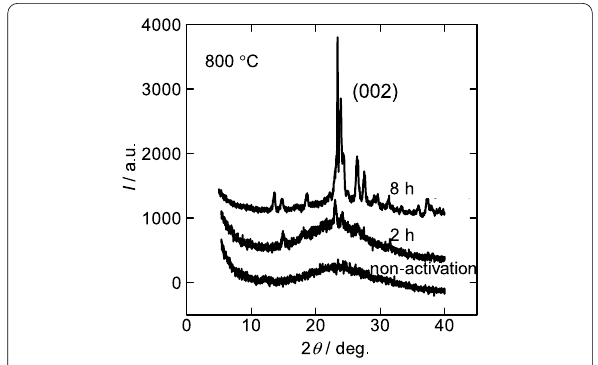
Fig. 1 Wide-angle X-ray diffraction (WAXD) intensity, I , profiles of non-activated carbon, and 2-h- and 8-h-activated carbons